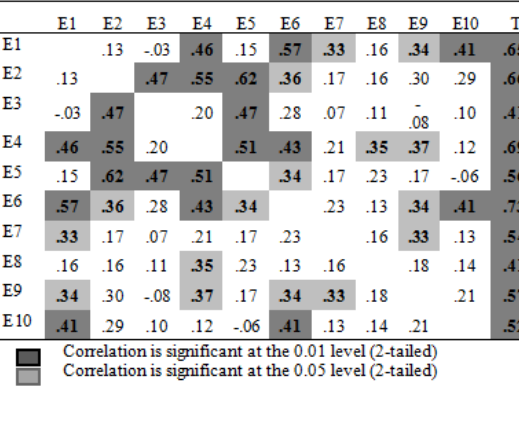
Table 2. Correlation matrix of the final